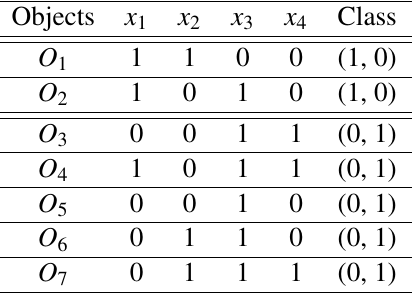
Table 2. Training matrix of